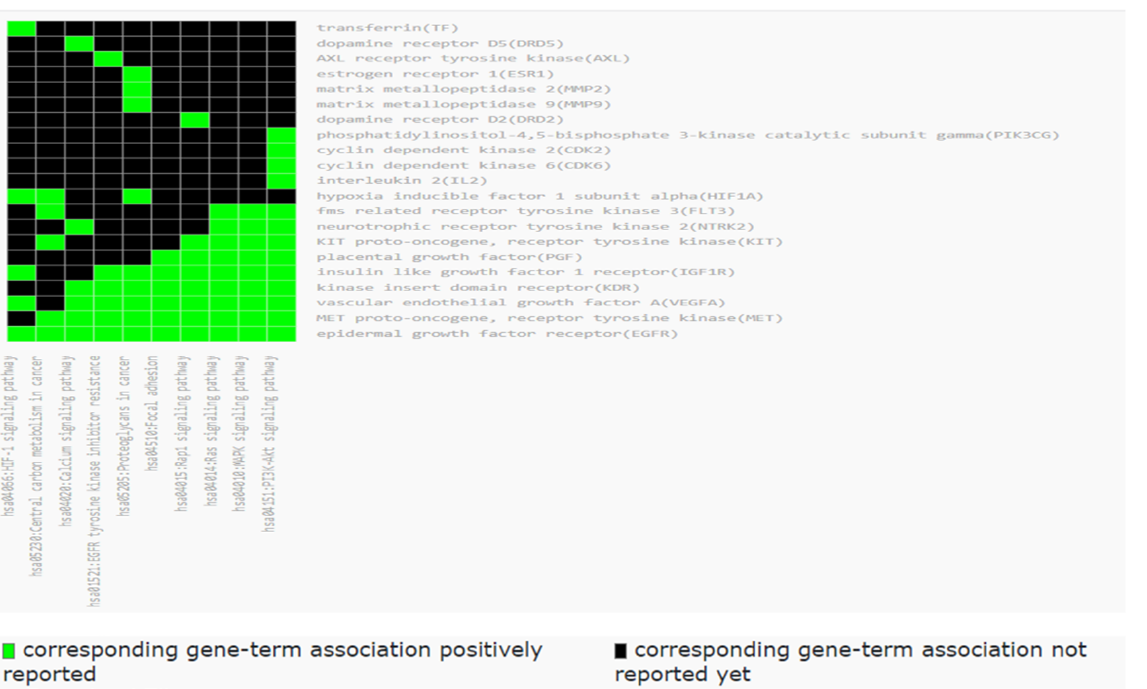
Figure 8. Functional annotation clustering of the KEGG pathways related to all targets of Olea europaea L. cv. Picual active metabolites; the results were obtained by the DAVID